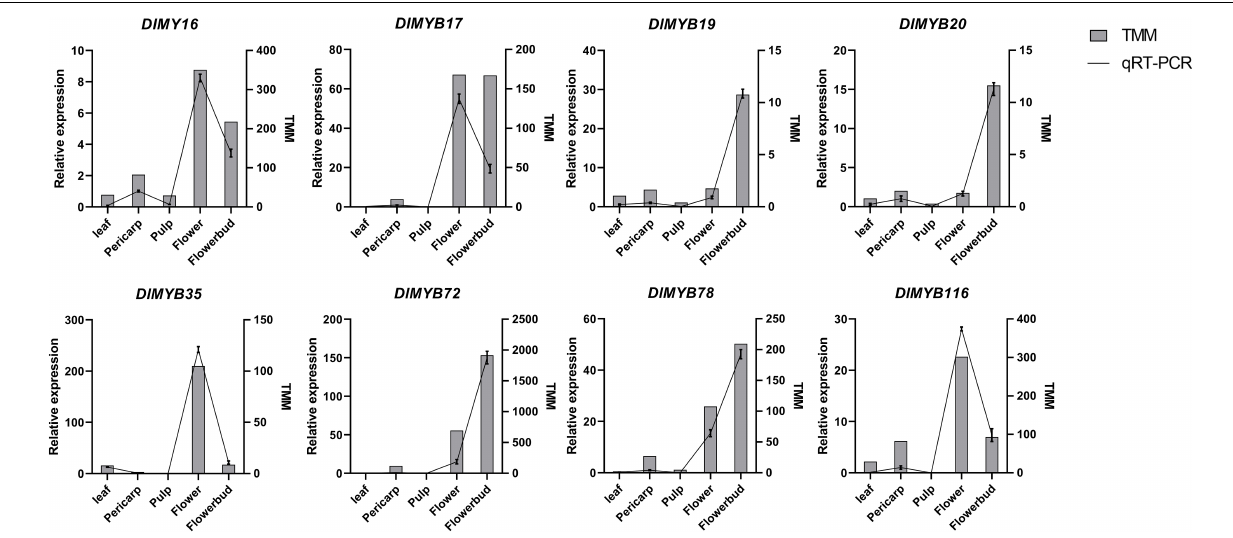
FIGURE 9 | qRT-PCR and RNA-seq analyses of eight selected DlMYB genes. The samples from flowers, flower buds, leaves, pulps, and pericarps show a range of expression changes of selected DlMYB genes. The left and right sides of the Y -axis indicate relative expression levels and TMM, respectively. To confirm the tissue-specific expression of the DlMYB genes, the expression pattern of selected DlMYB genes was calculated as a fold relative to the expression level of the